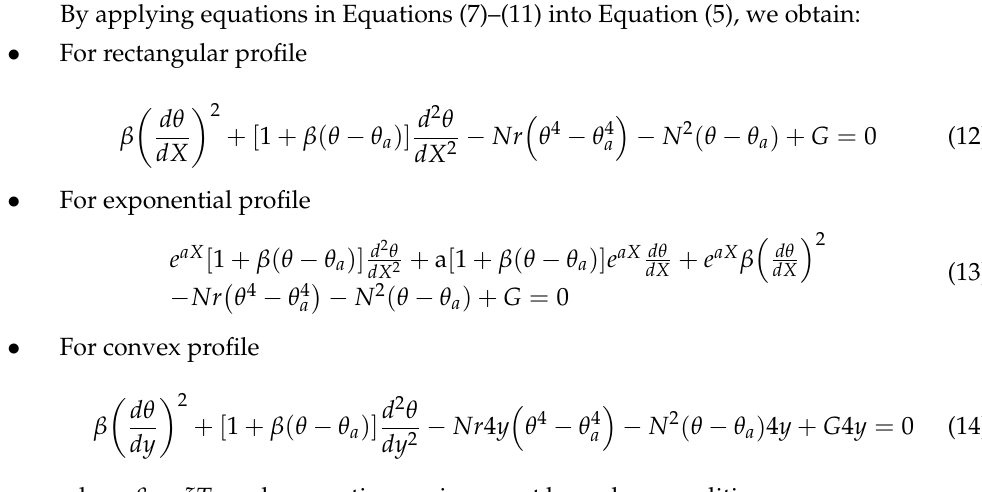
Figure 2. Schematic representation of fins with different profiles.